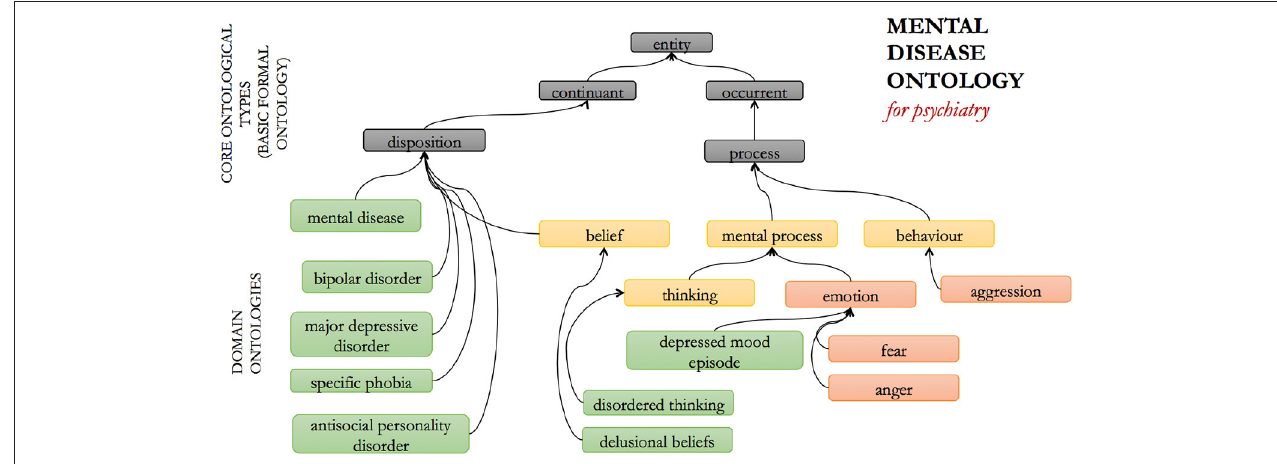
FIGURE 4 | The mental disease (MD) ontology: selected entities and